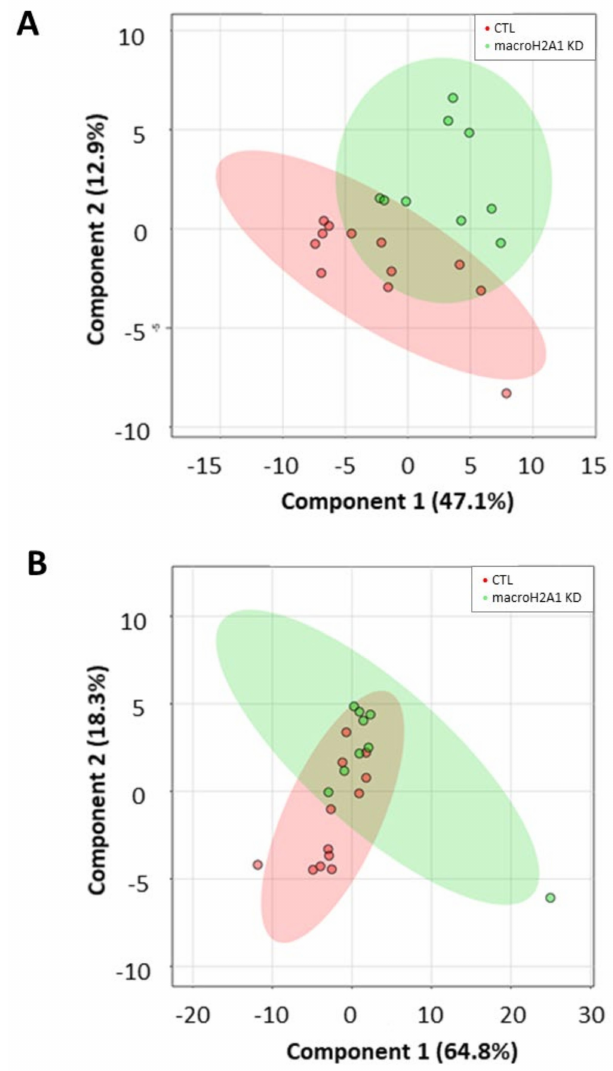
Figure 6. Discriminant ability of lipid signature in Huh-7 / HepG2 cells depleted for macroH2A1. ( A ) Partial least squares discriminant analysis (PLS-DA) score plot showing separation between KD Huh-7 cells (green) and control cells (red). ( B ) PLS-DA score plot showing separation between KD HepG2 cells (green) and control cells (red). Number in parentheses is the percentage of explained variation. With respect to cells depleted for FAK, the PLS-DA score plot in Figure 7A indicates a good discrimination in Huh-7 cells. In contrast, no clear separation between FAK KD and control cells is evident for the HepG2 cell line (Figure